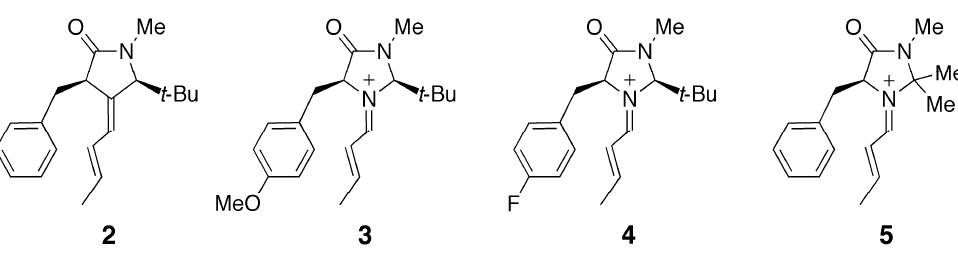
Figure 1. Structural formulas of the species related to the iminium intermediate 1